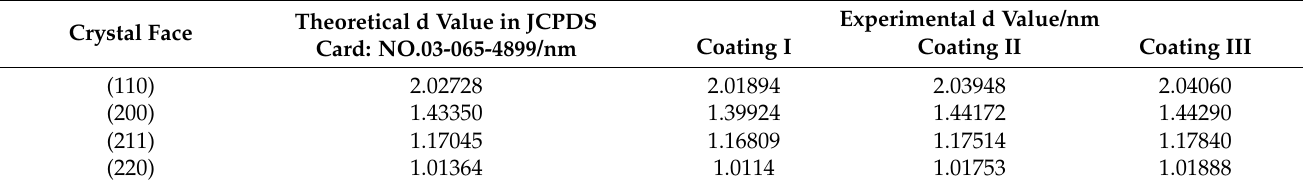
Figure 1. X-ray diffraction patterns of the coatings. Table 1. Comparison of d value related to BCC among the coatings.